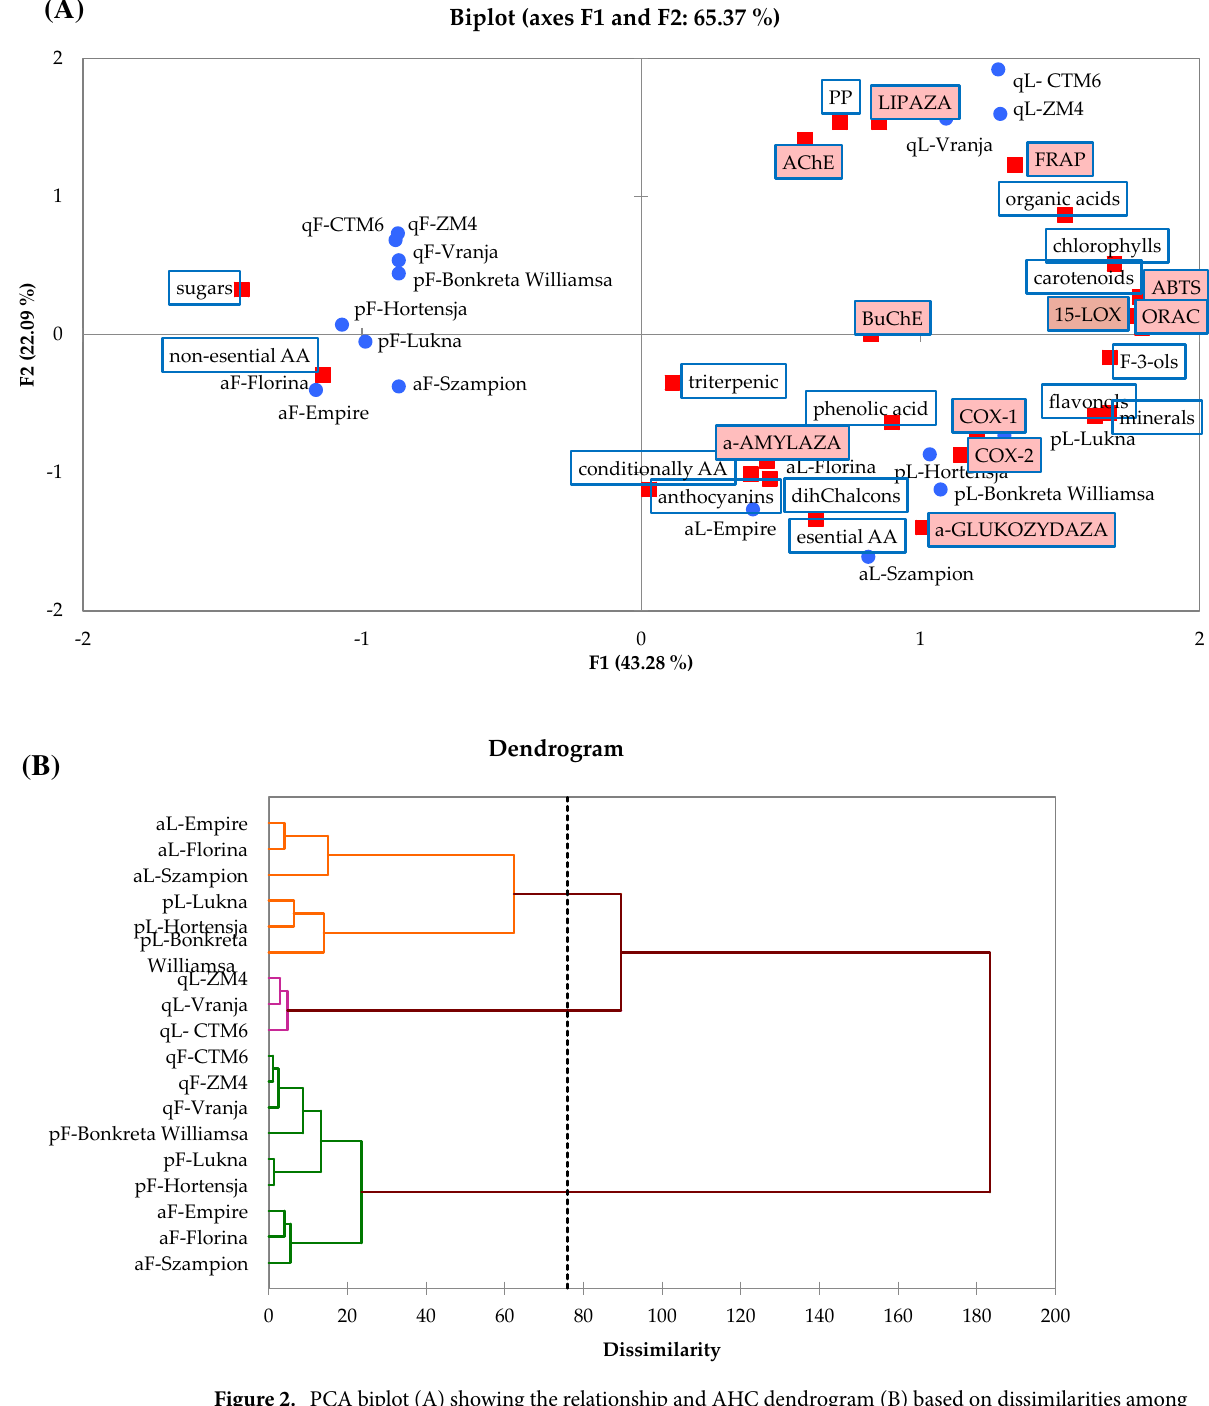
Figure 2. PCA biplot (A) showing the relationship and AHC dendrogram (B) based on dissimilarities among samples and chemical constituents with respect to apple (a), pear (p), quince (q) fruit (F) and leaves (L)